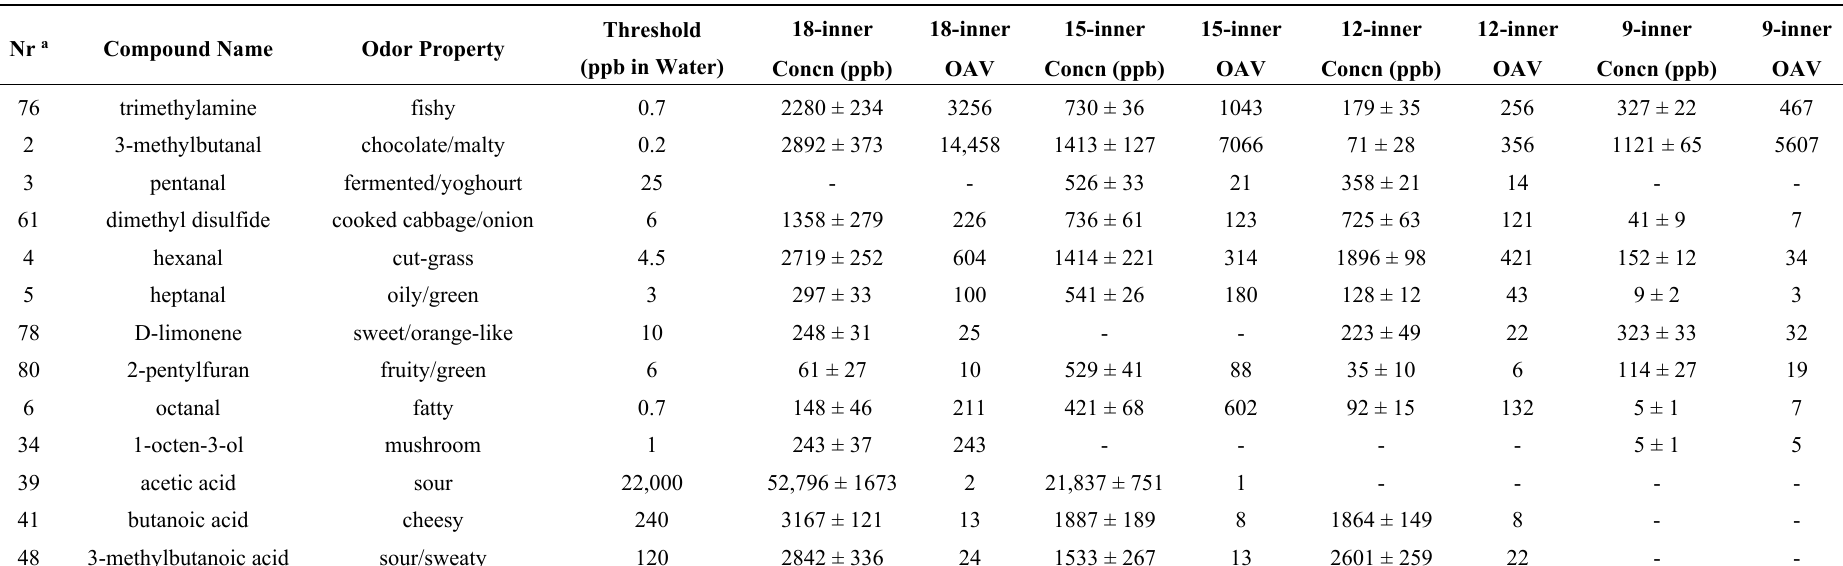
Table 2. OAVs of predominant odorants in Jinhua hams by DHS.